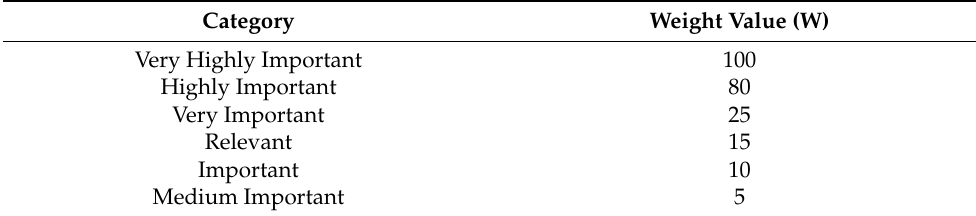
Table 7. Weight values in